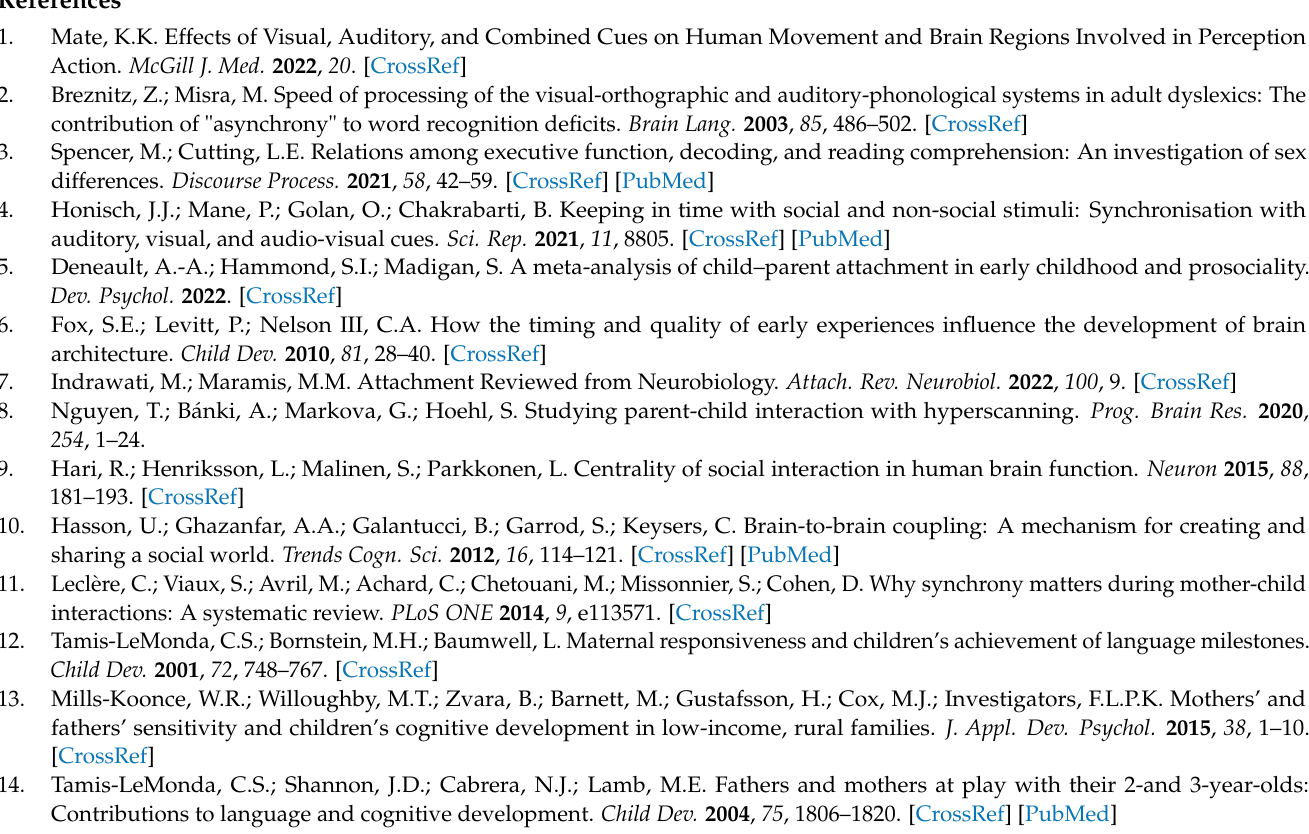
Figure 2. Suggested developmental progress of synchronization between the mother and child from pregnancy to reading age.